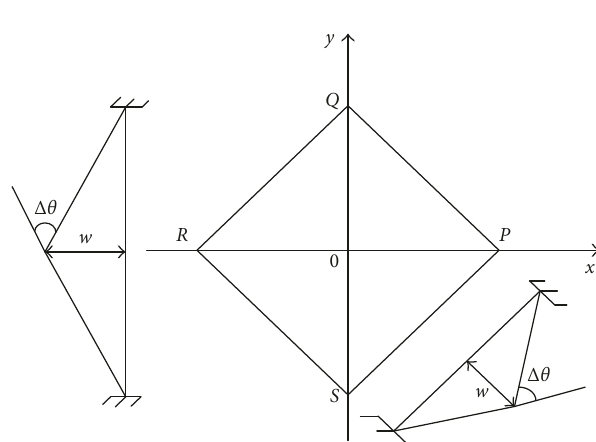
Figure 4: Deformation diagram of the plate.